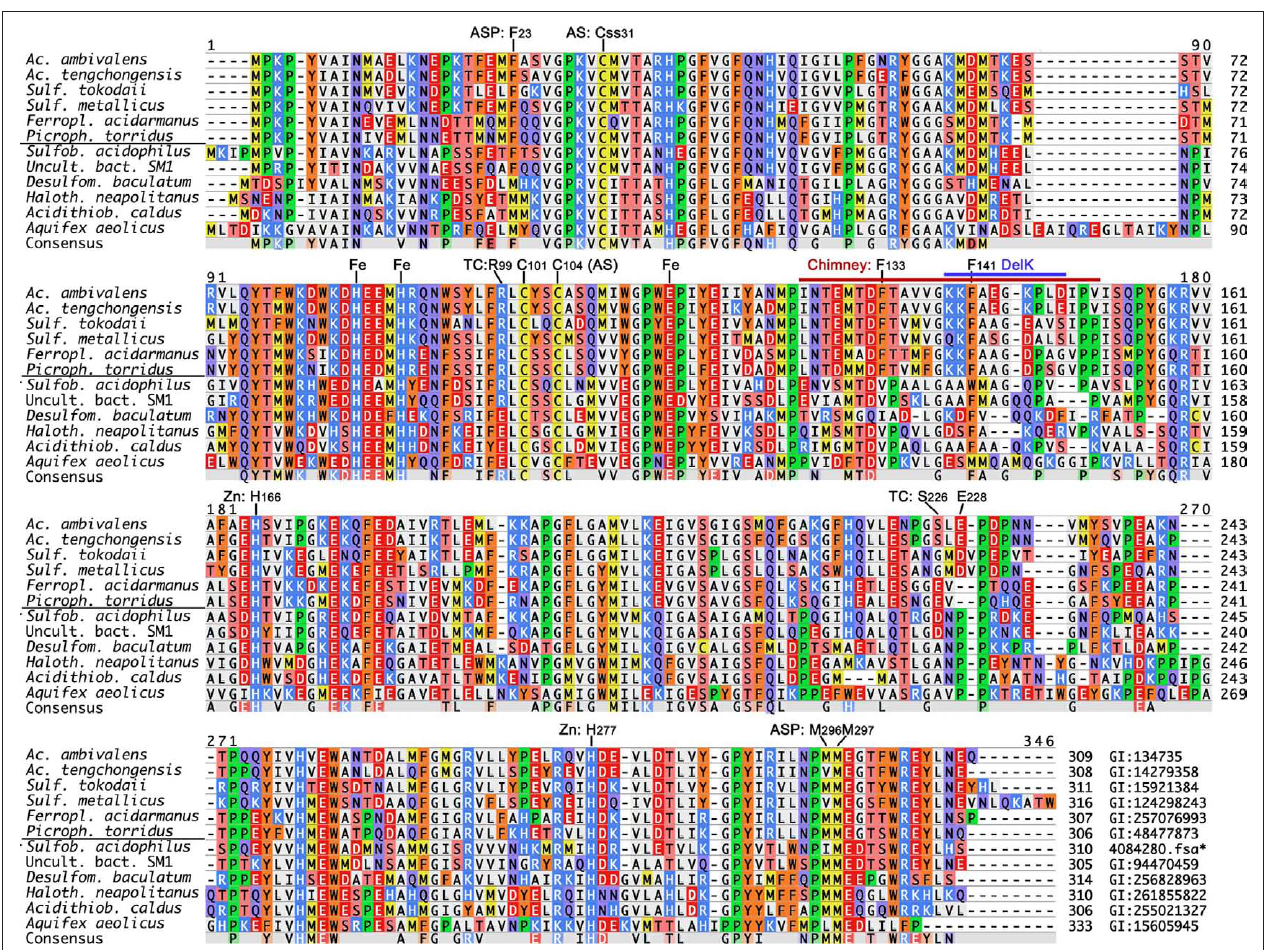
FiguRe 1 | Multiple alignments of known and complete SOR amino acid sequences from isolated proteins and from genome sequences. PCR- generated fragments with high similarity to the Acidianus enzymes (Chen et al., 2007) were omitted. Genbank identification (GI) numbers are given at the end; *derived from the genome sequence available at JGI 1 . The horizontal line separates